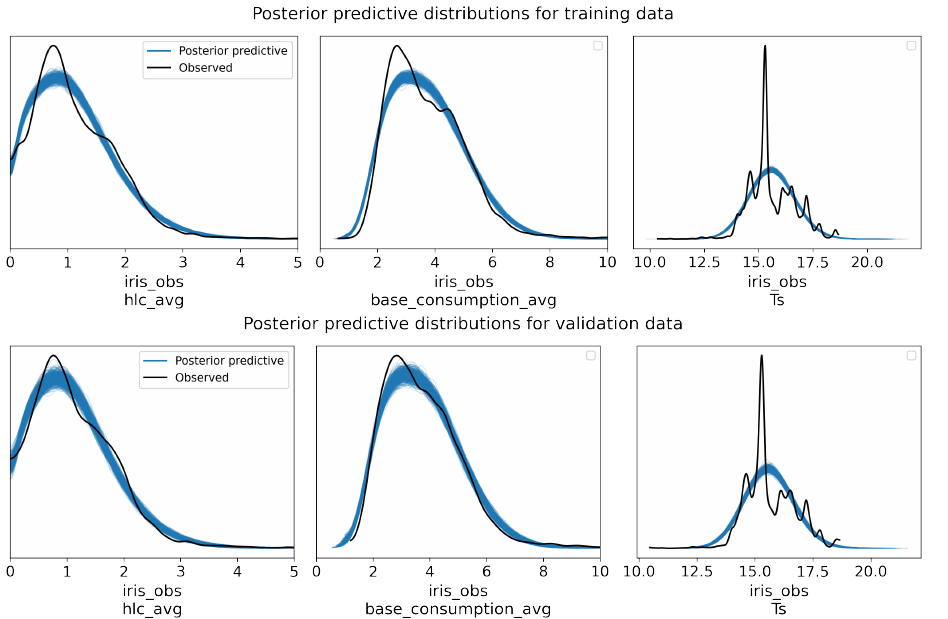
Figure 8. Posterior predictive distributions for training and validation data—apartments and houses